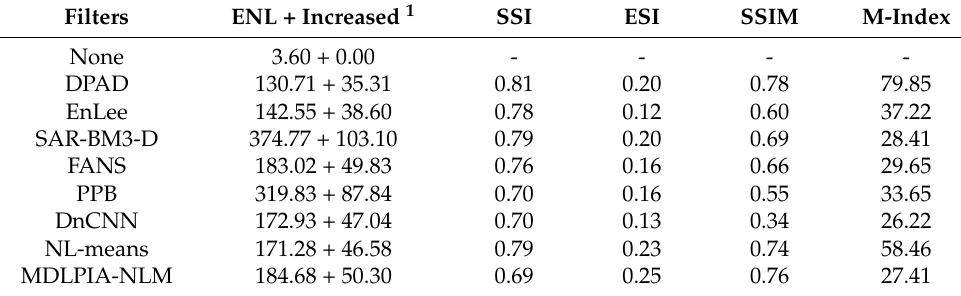
Table 6. Index evaluation for the ALOS-2 SAR